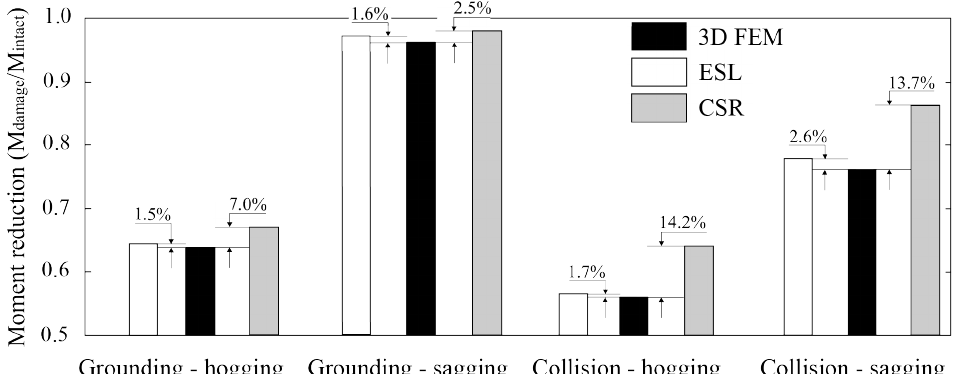
Figure 16. The moment reduction ratio under grounding and collision damage in the hogging and sagging conditions using the 3D FEM, ESL, and CSR